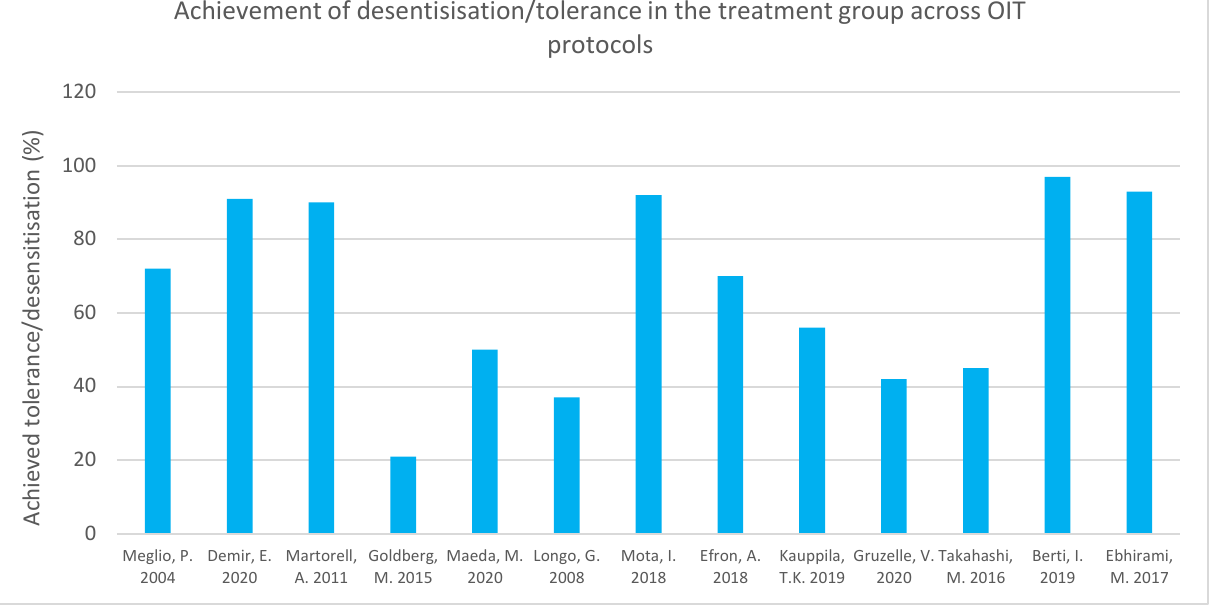
Figure 6. Tolerance/desensitization achievement in treatment groups across protocols [66-69, 71- 76, 78-80].